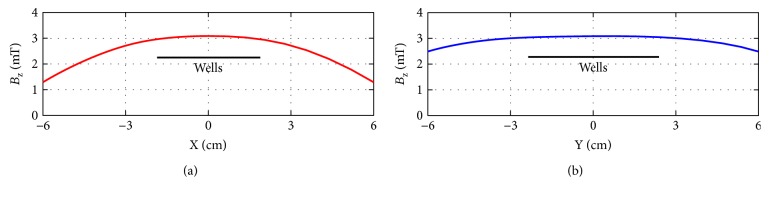
Magnetic induction field. Vertical component BZ (in the Z direction) of the magnetic induction field B inside the electromagnetic bioreactor versus the X and the Y directions (panels (a) and (b), resp.). BX and BY were negligible. The wells used for cell culture were in the region of field's quasihomogeneity (black horizontal lines in the center of the bioreactor).